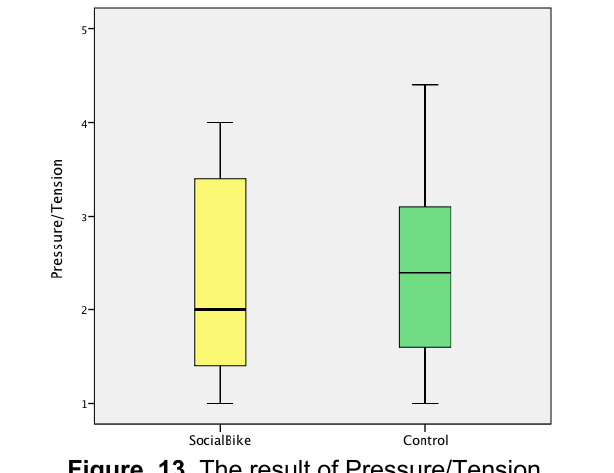
Figure. 13. The result of Pressure/Tension (ranges from 1-7).